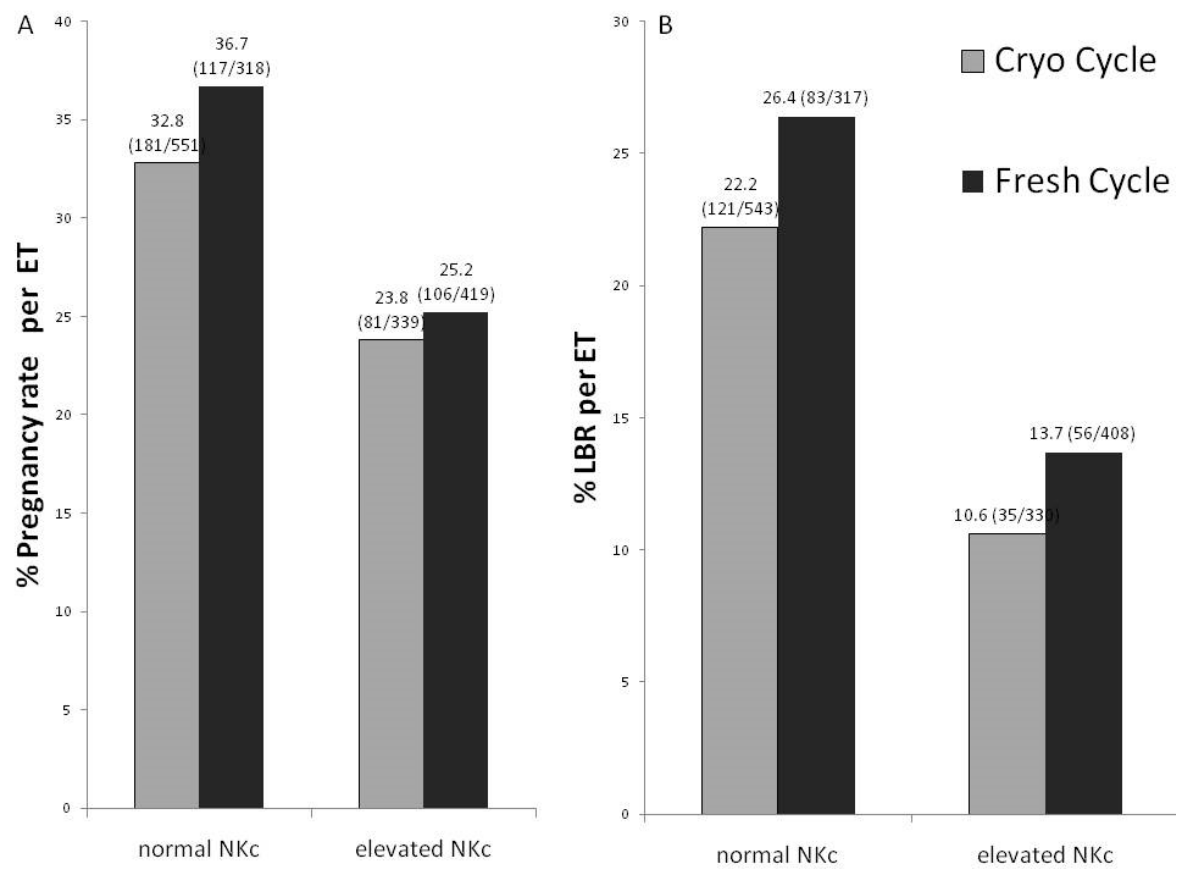
Figure 2. Clinical pregnancy rate ( A ) and live-birth rates ( B ) in patients with normal NKc and elevated NKc that have undergone fresh ET (in stimulated cycles) or cryo-ET in non-stimulated cycles. Both were calculated per ET and no significant difference was found.